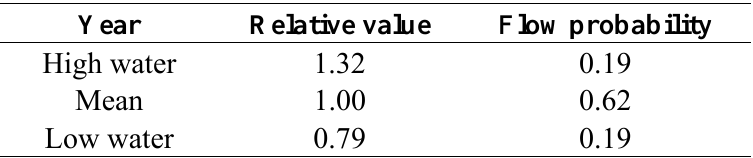
Table 1. Inflow probability into the Papan